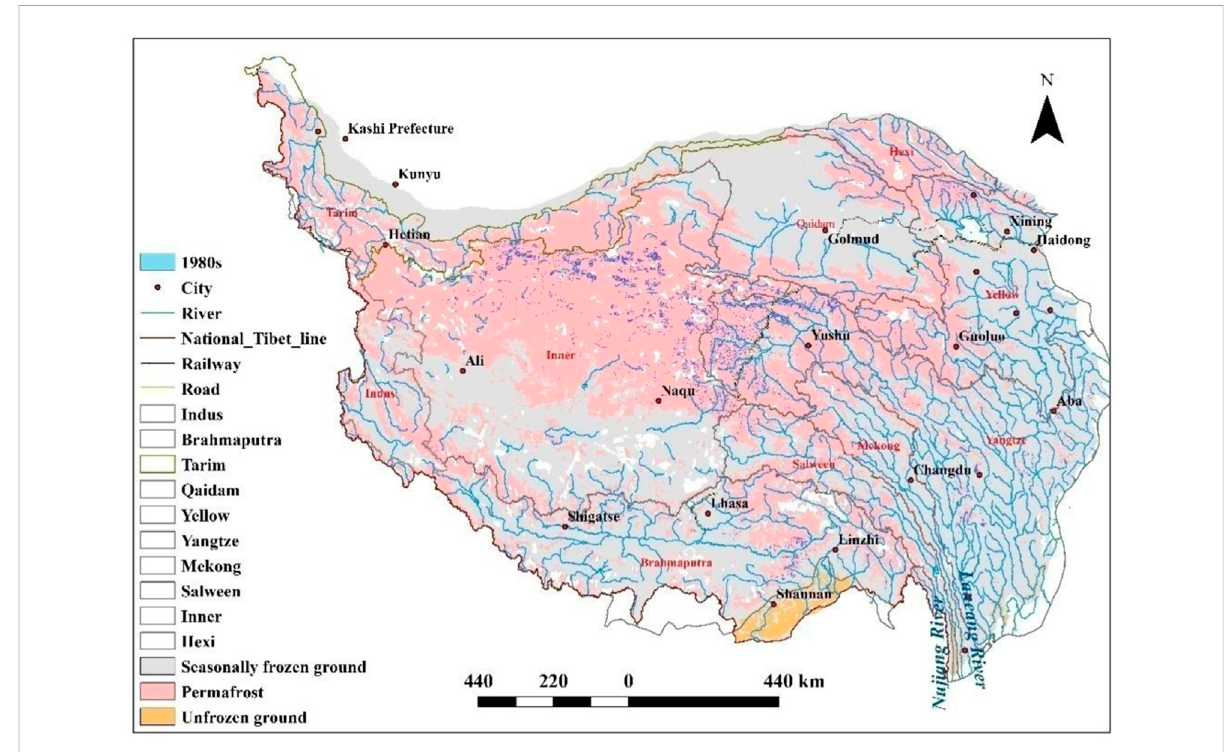
FIGURE 1 Thermokarst lakes in